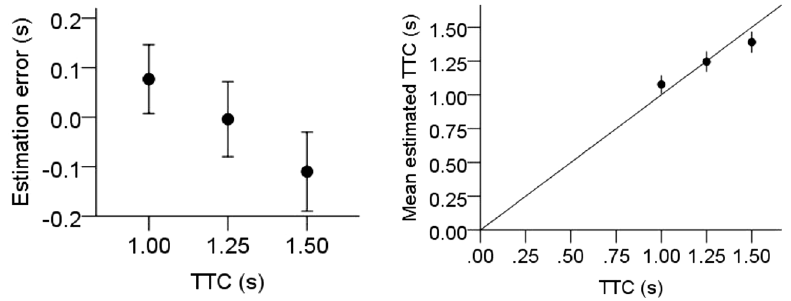
Figure 10. Left: Mean TTC estimation errors (estimated TTC—actual TTC) as a function of actual TTC. Right: TTC estimates as a function of actual TTC. Error bars represent ± 1 standard error of the mean across